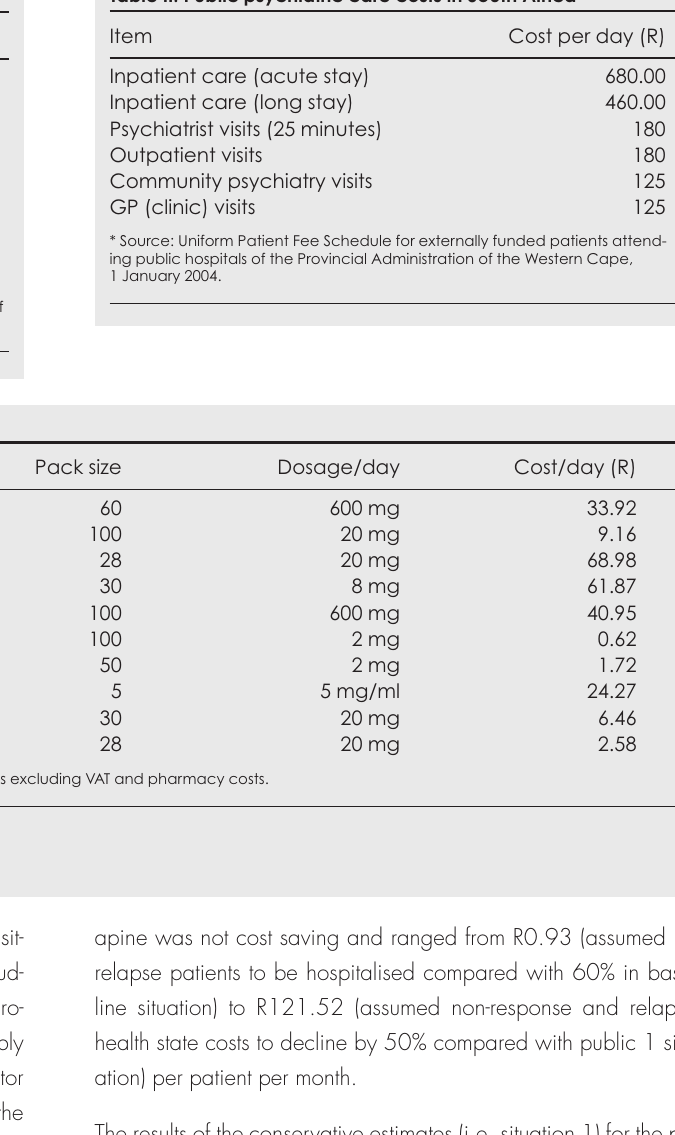
Table I. Private psychiatric care costs in South Africa* Table II. Public psychiatric care costs in South Africa*